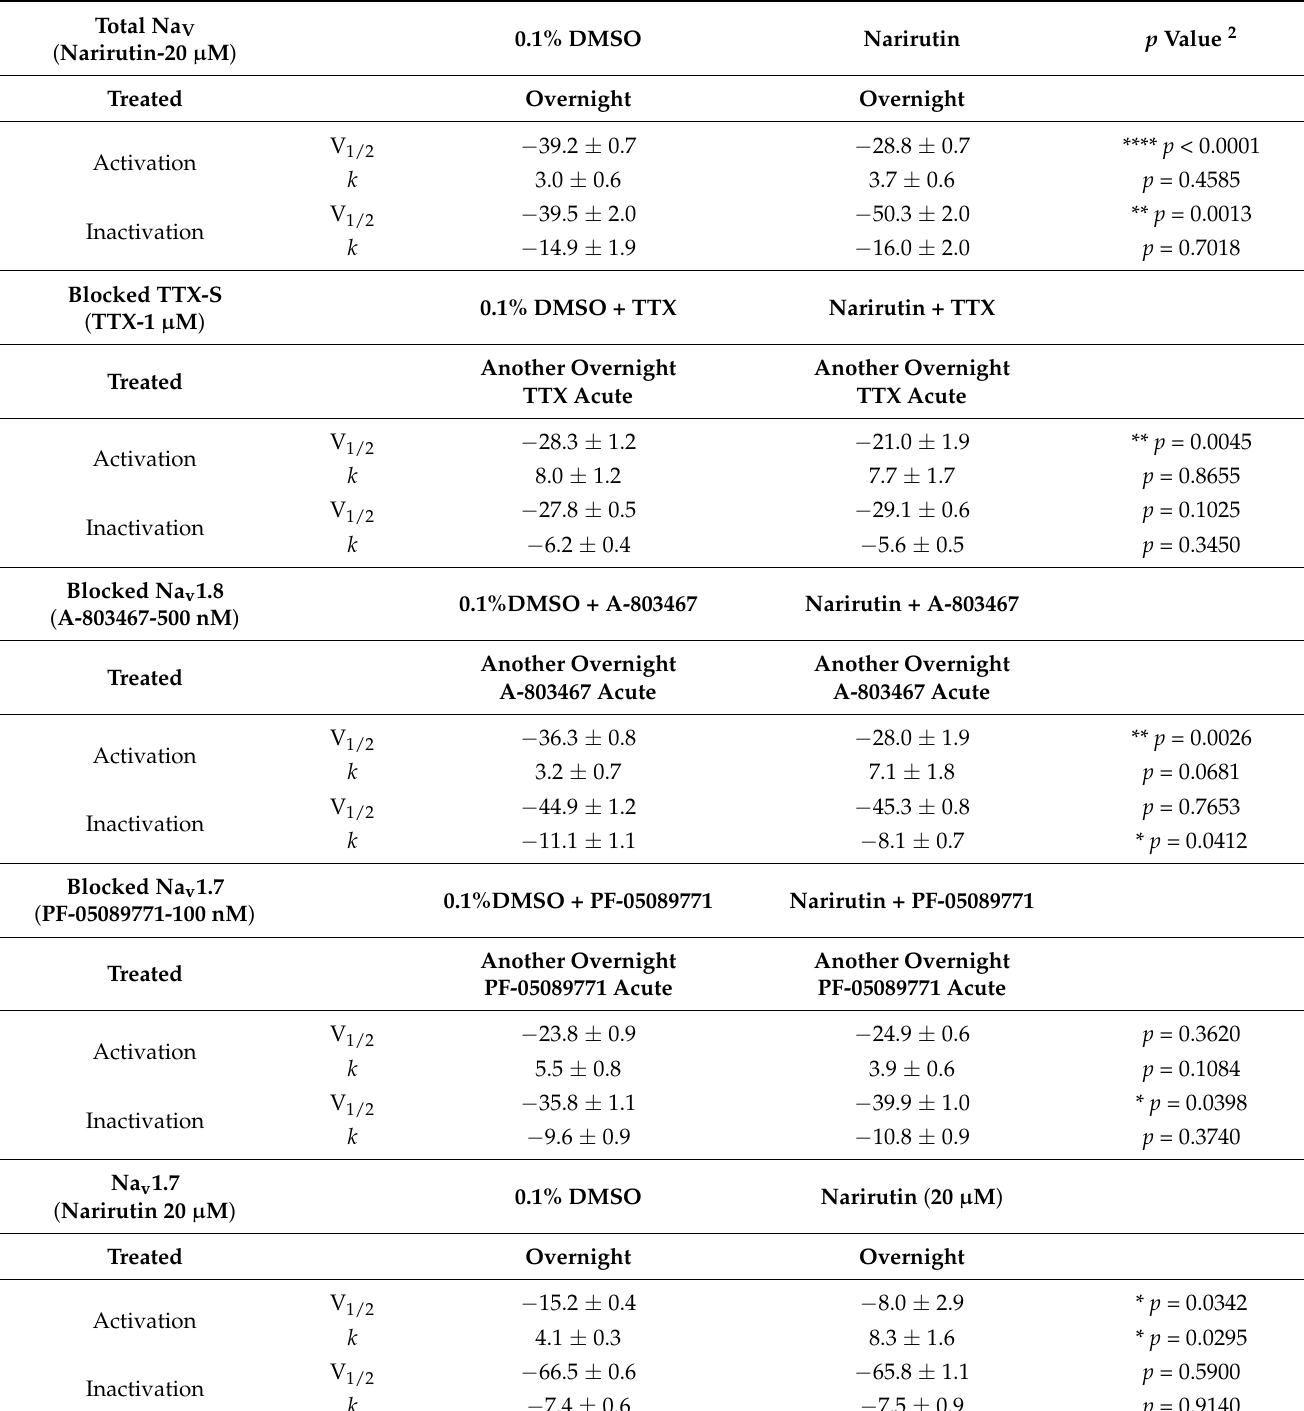
Table 1. Effects of Narirutin on Gating Properties of Voltage-gated Channels in DRG Neurons and HEK cell line 1